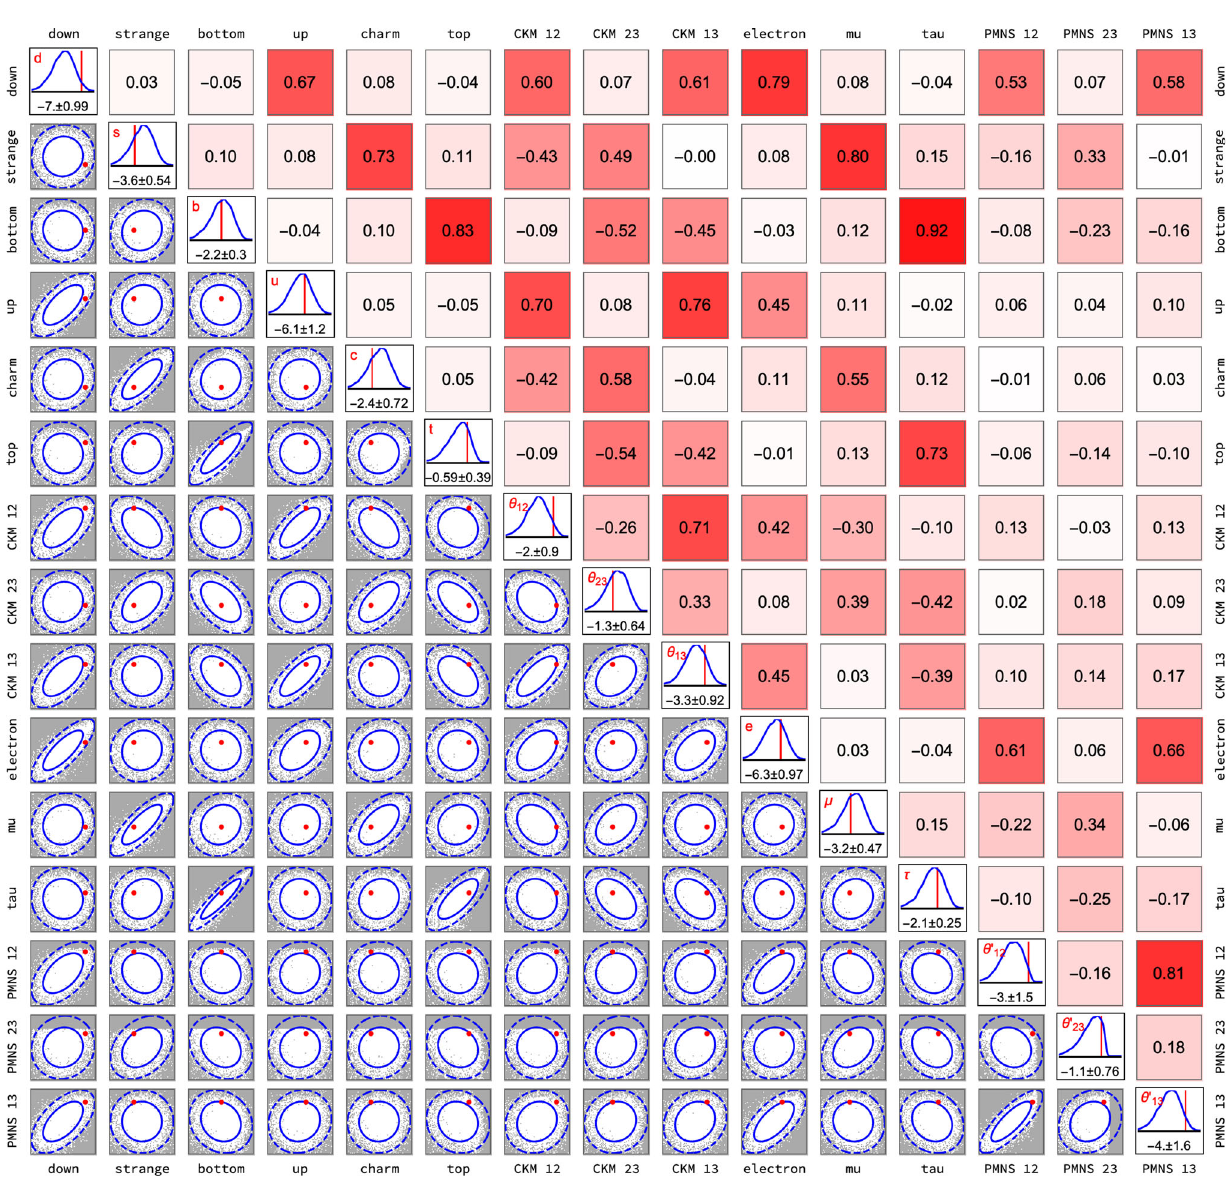
marginal distributions over a 3 sigma range with the red lines indicating the experimental value. The numbers on the bottom of each entry are the mean and standard deviation. In the upper triangle, we show the correlation